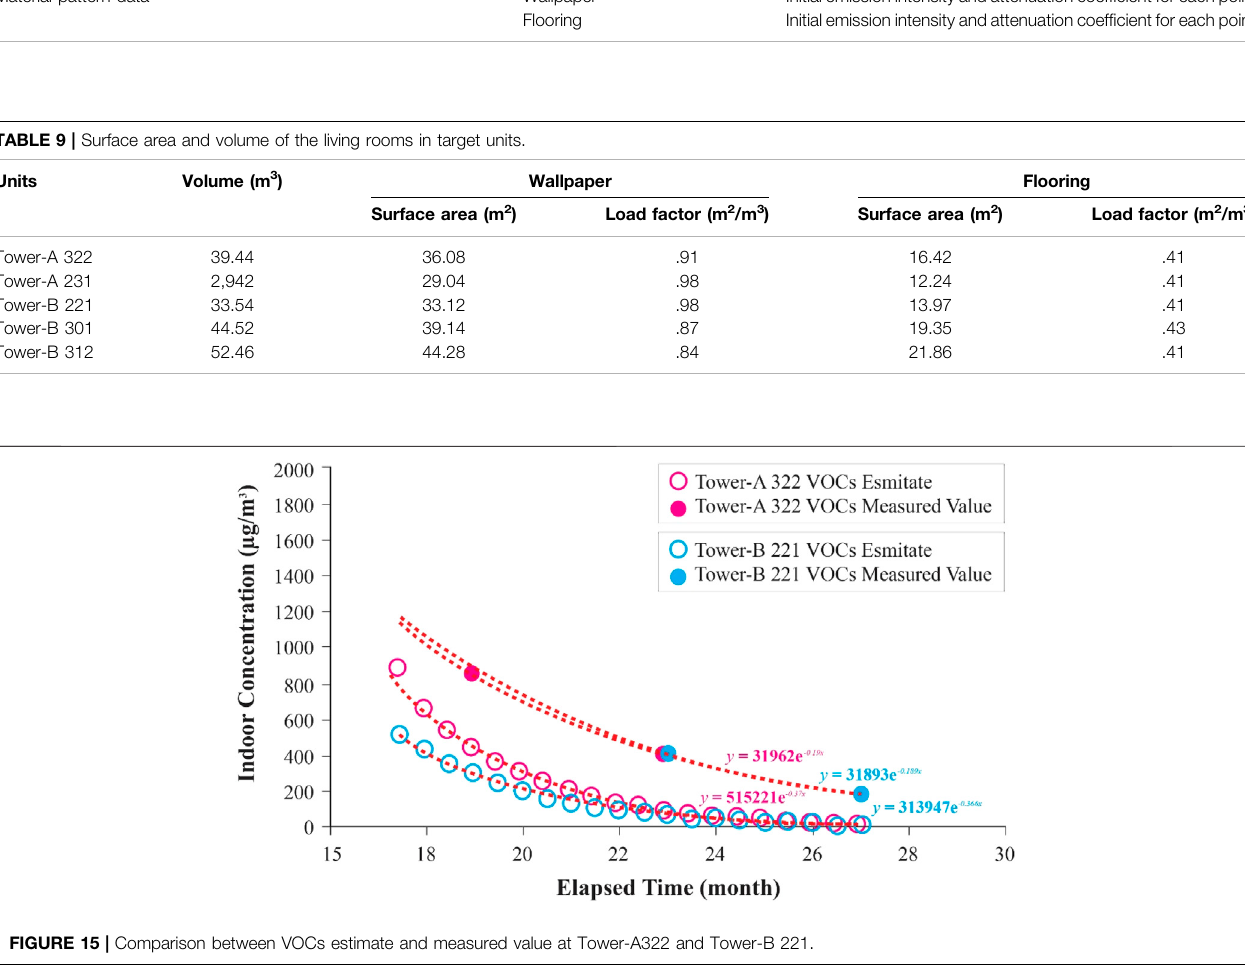
Frontiers in Built Environment |